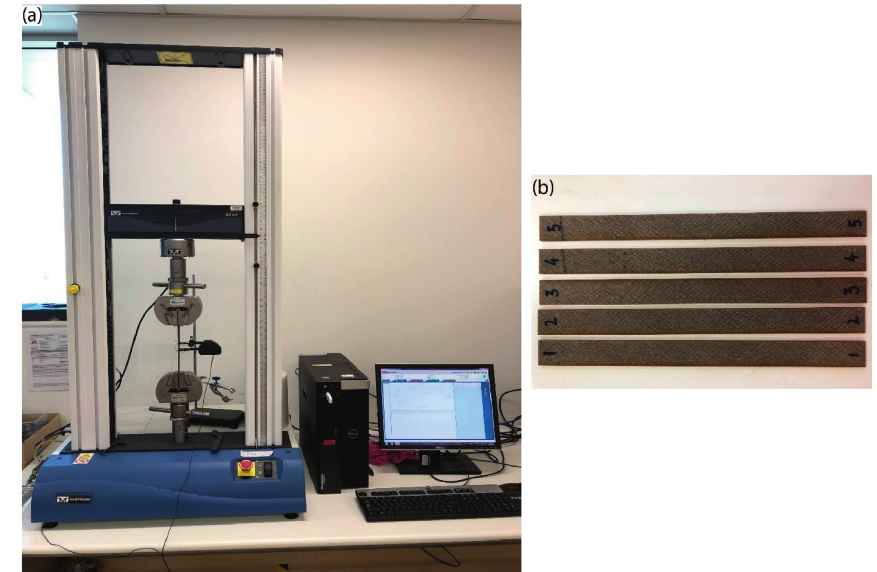
Figure 2: Experimental setup (a) and in-plane shear specimens (b).